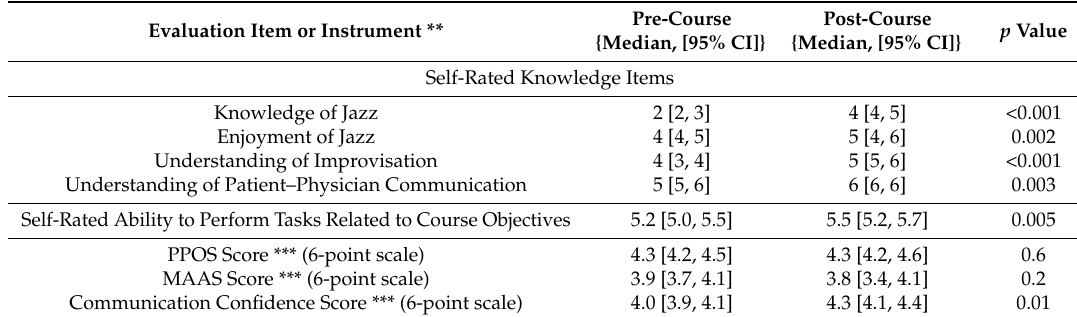
Table 1. Student Survey Results